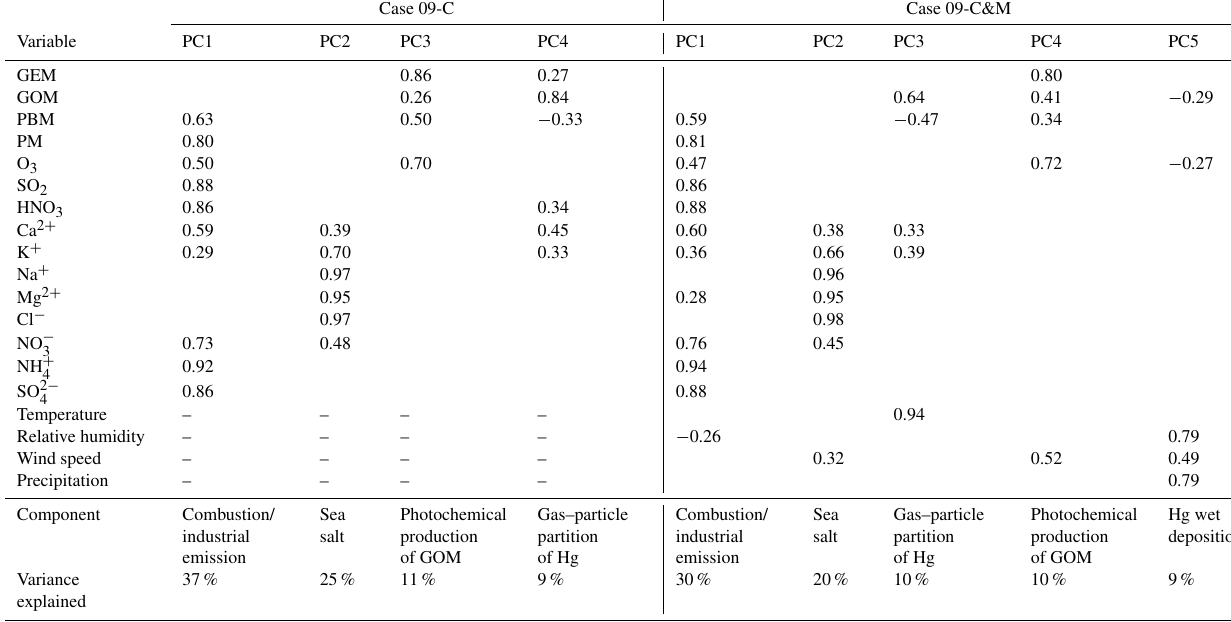
Table 7. PCA component loadings (>0.25) of Case 09-C and Case